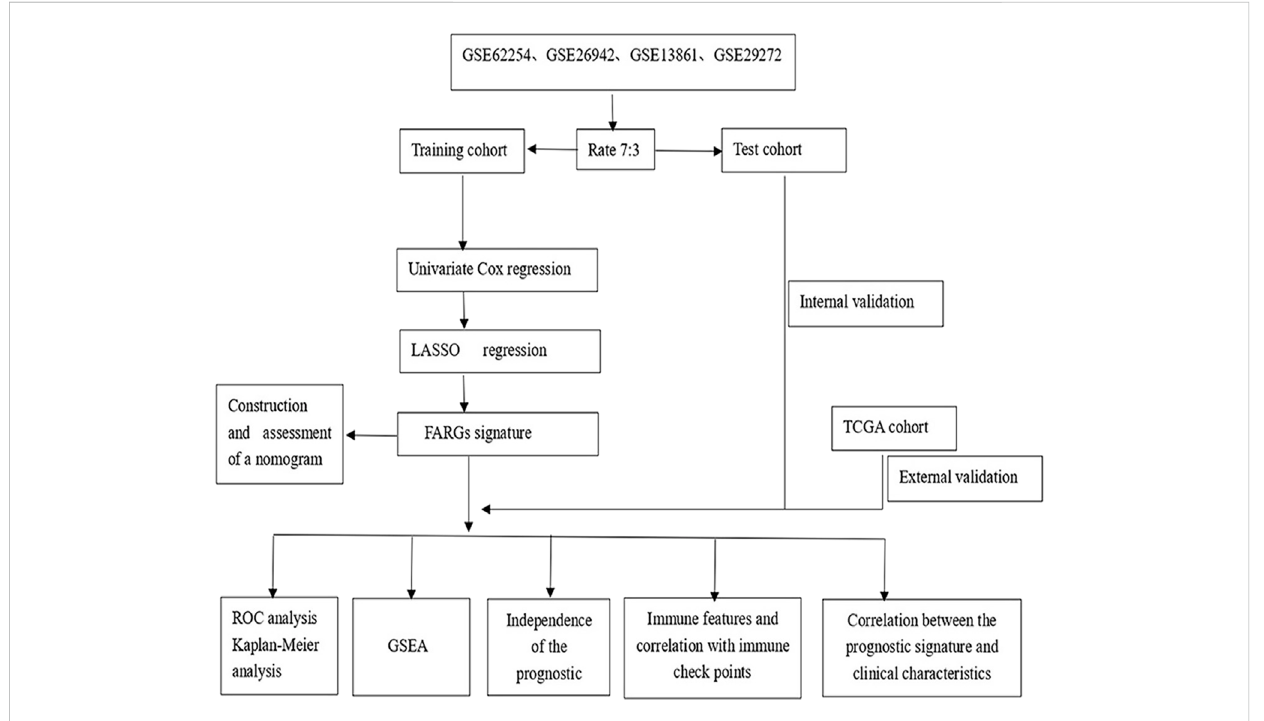
FIGURE 1 The fow chart showing the scheme of our study on focal adhesion prognostic signatures in